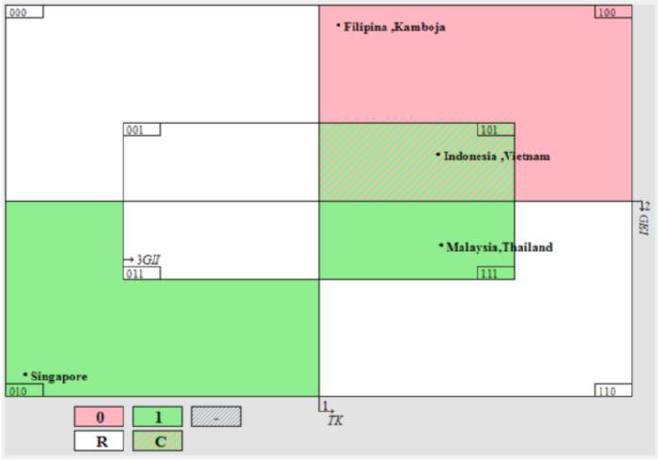
Figure 2: Venn Diagram QCA Analysis; Source: processed data,